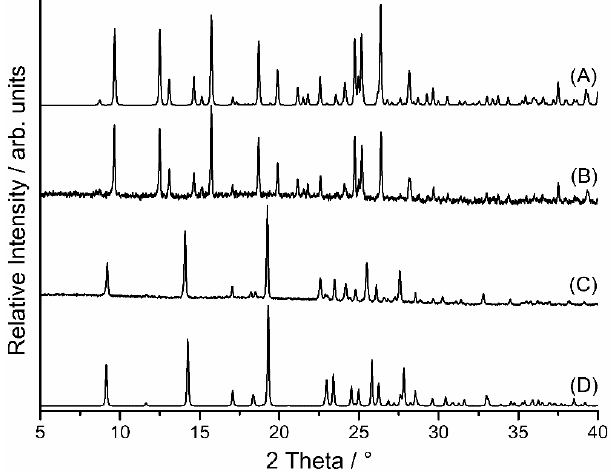
Figure 9. Calculated XRPD patterns of 5 ( A ) and 3 ( D ). The experimental XRPD patterns of the residue obtained after the first mass step ( B ); and of the product obtained after stirring compound 5 in water for 3 d ( C ).